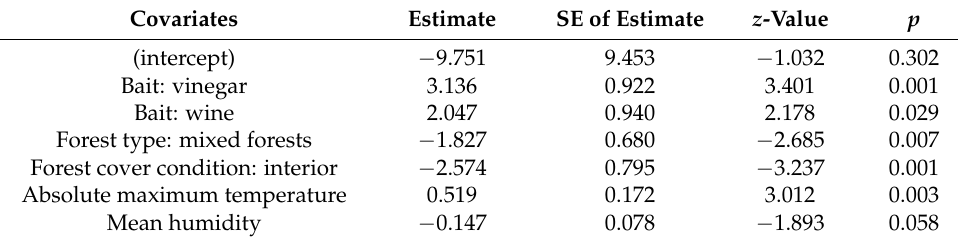
Table 6. Popillia japonica . Effectiveness of baits in attracting individuals of the species, account- ing for the effects of habitat and meteorological covariates considered in the negative binomial regression